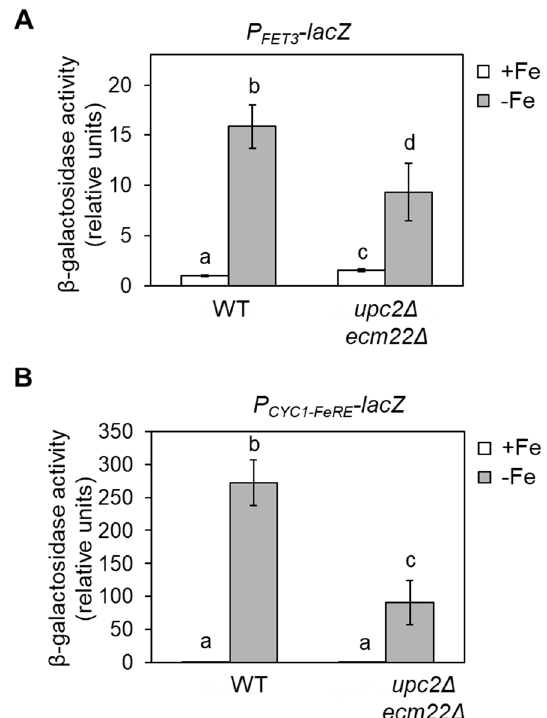
Figure 6. Upc2/Ecm22 regulation via promoter iron-regulatory elements. ( A ) Upc2/Ecm22-dependent activation of FET3 upon iron deficiency occurs through its promoter. Wild-type (WT, W303) and upc2 ∆ ecm22 ∆ cells expressing P FET3 -lacZ were grown at 30 ◦ C in SC-Ura medium without (+Fe) or with 100 µ M BPS ( − Fe) for 6 h, and β -galactosidase activity was determined. Significant differences are represented by different letters above bars ( p -value < 0.05). ( B ) FeRE sites are required for Upc2/Ecm22-mediated induction of transcription. Wild-type (WT, W303) and upc2 ∆ ecm22 ∆ cells expressing P CYC1-FeRE –lacZ were grown and analyzed as indicated in panel A. Data show the average and SD of three biologically independent experiments as compared to wild-type (+Fe) samples. Letters above bars indicate significant differences ( p -value < 0.05).